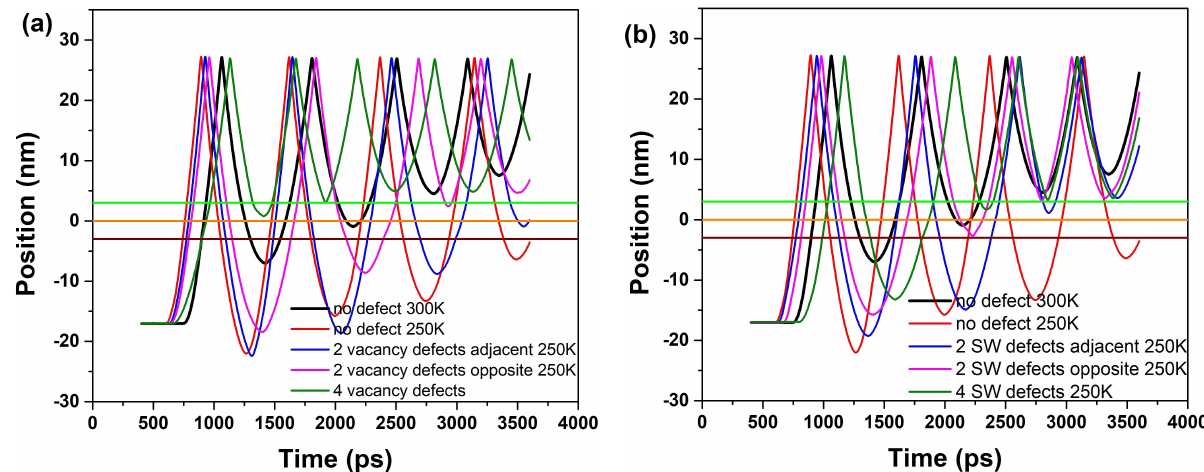
Figure 11: Variation of the movement behaviors with time for the system in 250K and 300K: (a) The system containing no defect, 2 vacancy defects adjacent, 2 vacancy defects opposite, 4 SW defects in the inner nanotube, (b) The system containing no defect, 2 SW defects adjacent, 2 SW defects opposite, 4 SW defects in the inner nanotube